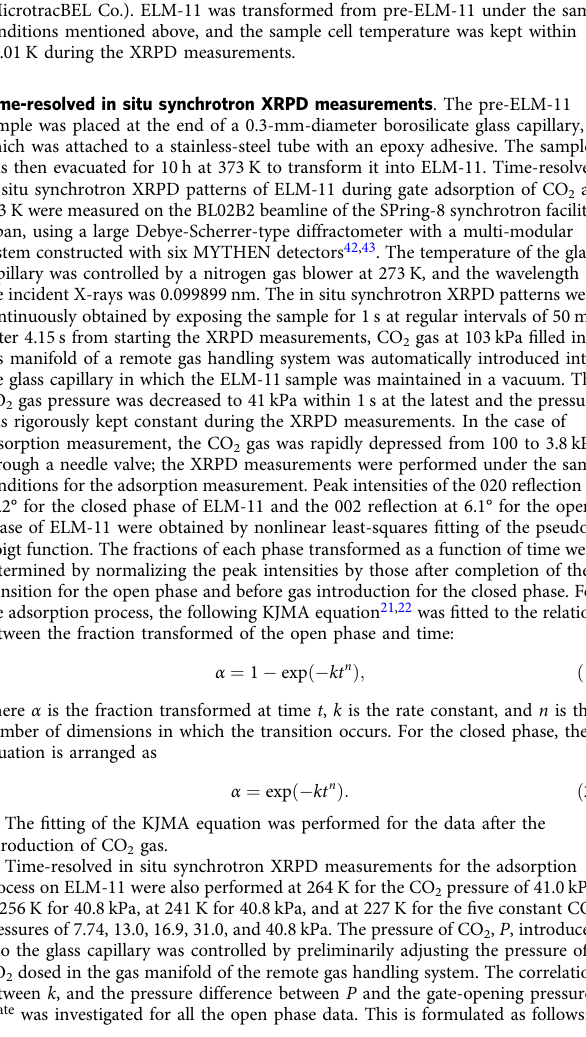
Fig. 9. The regular speci fi c heat of HKUST-1 at 298K was 0.78 J g − 1 K − 1